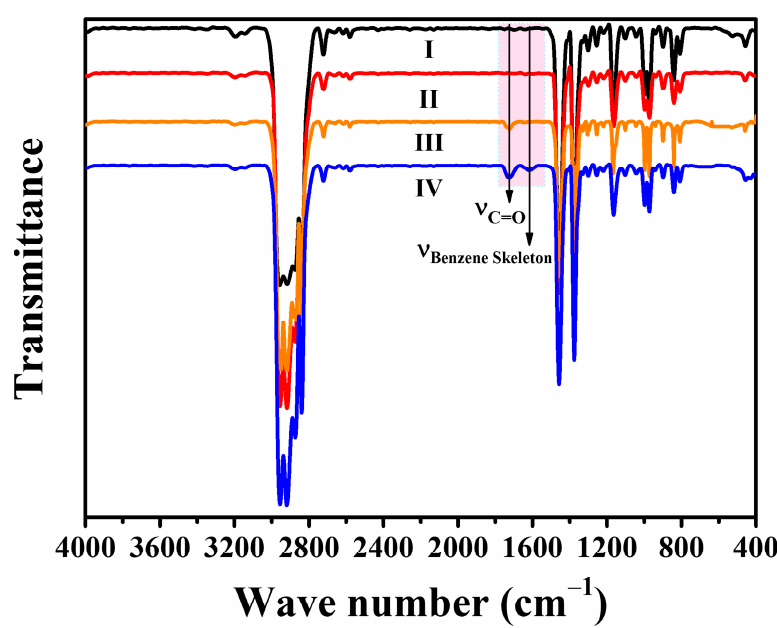
Figure 8. FTIR spectra of PP (I), purified PC1 (II), PG (III) and PGC3 (IV).